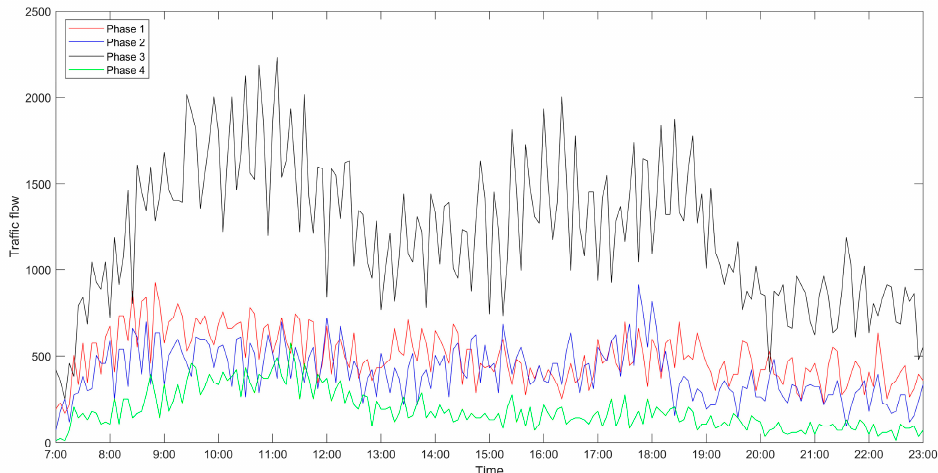
Figure 4. Traffic flow at the intersection of Wuhe Avenue and Zhangheng Road.